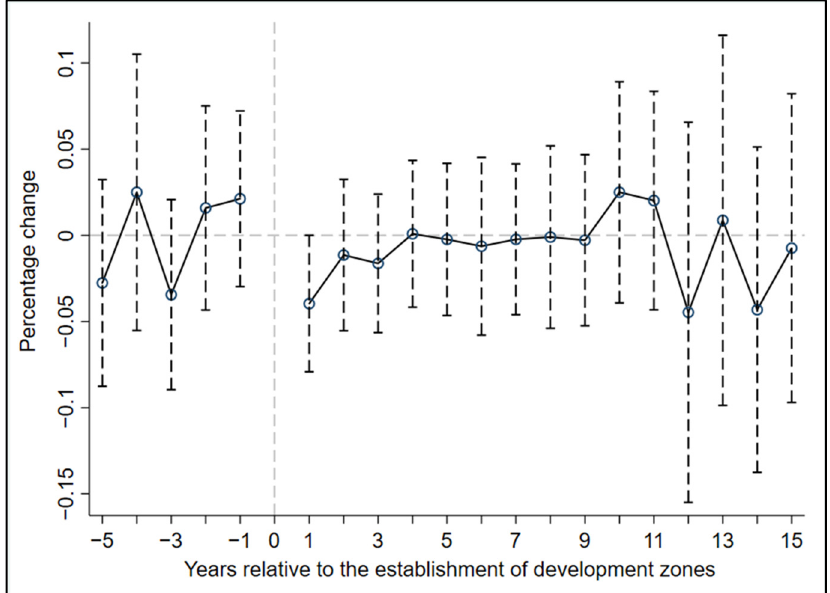
Figure 3. Dynamic impact of the establishment on the percentage change in the growth rate of GDP. Figure 3 plots the dynamic impact of development zones on the growth rate of GDP. The dashed lines represent 95% confidence intervals, adjusted for county-level clustering.